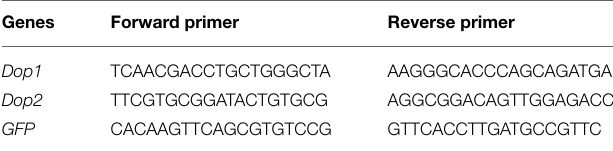
TABLE 2 | Primer sequences for